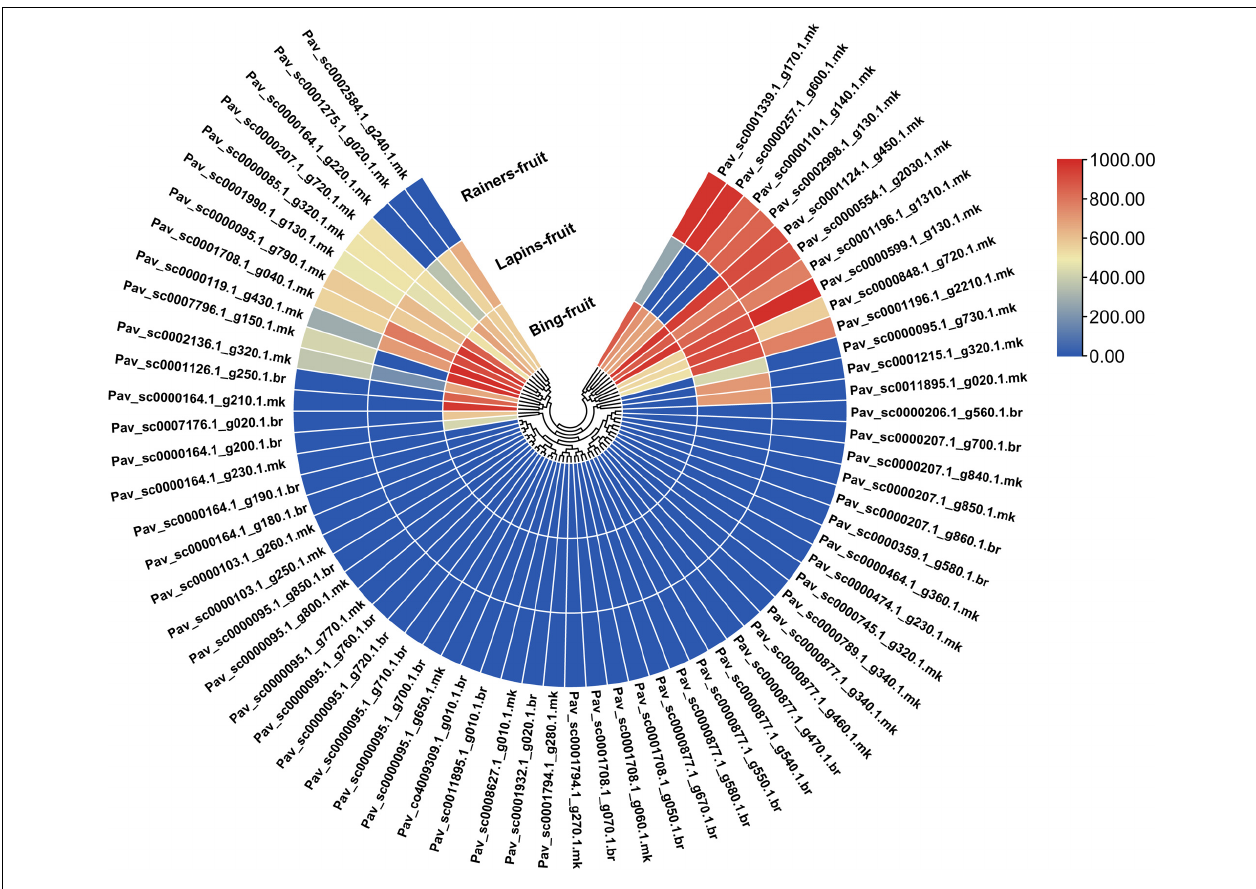
FIGURE 9 | Transcriptomic evaluation of 67 PavGST genes in the fruit of three sweet cherry cultivars (Bing, Lapin, Rainer). Different colors revealed expression intensity.